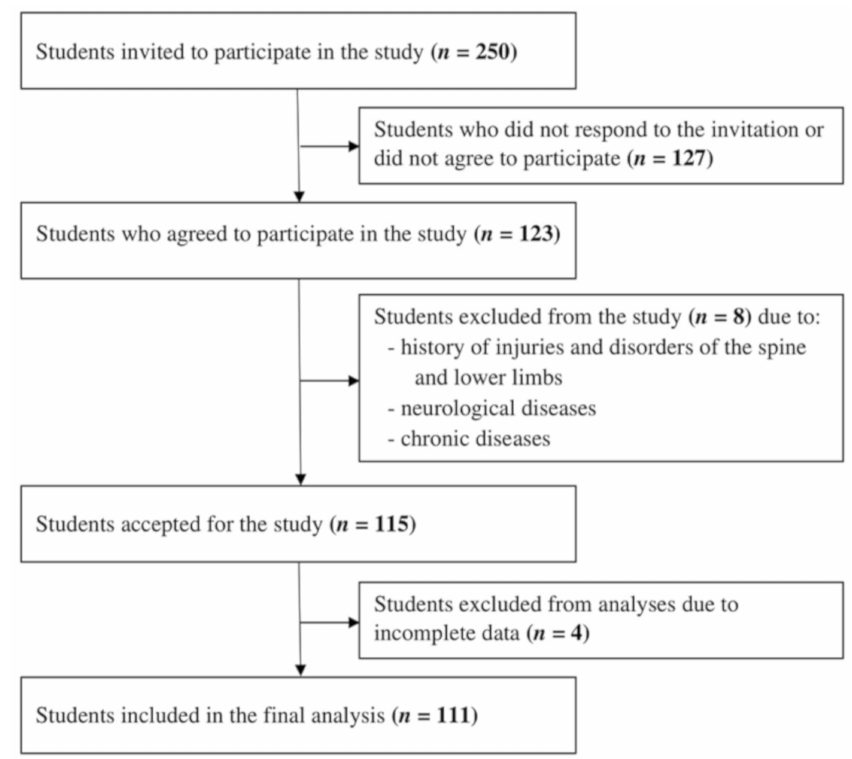
Figure 1. Study population selection